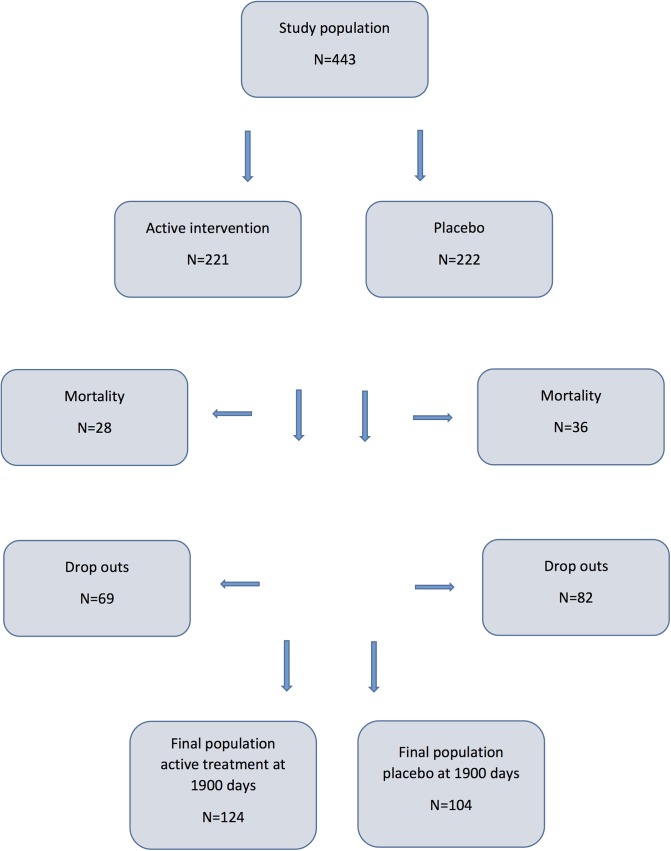
CONSORT diagram illustrating the design of the study.